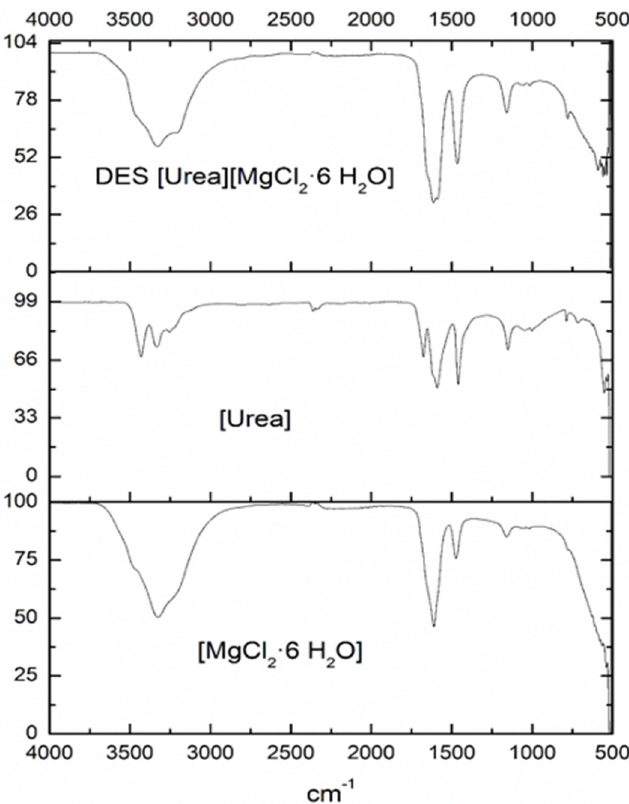
Figure 1. FTIR-ATR spectra of DES [MgCl 2 ·6 H 2 O] [U] proportion (1:1).